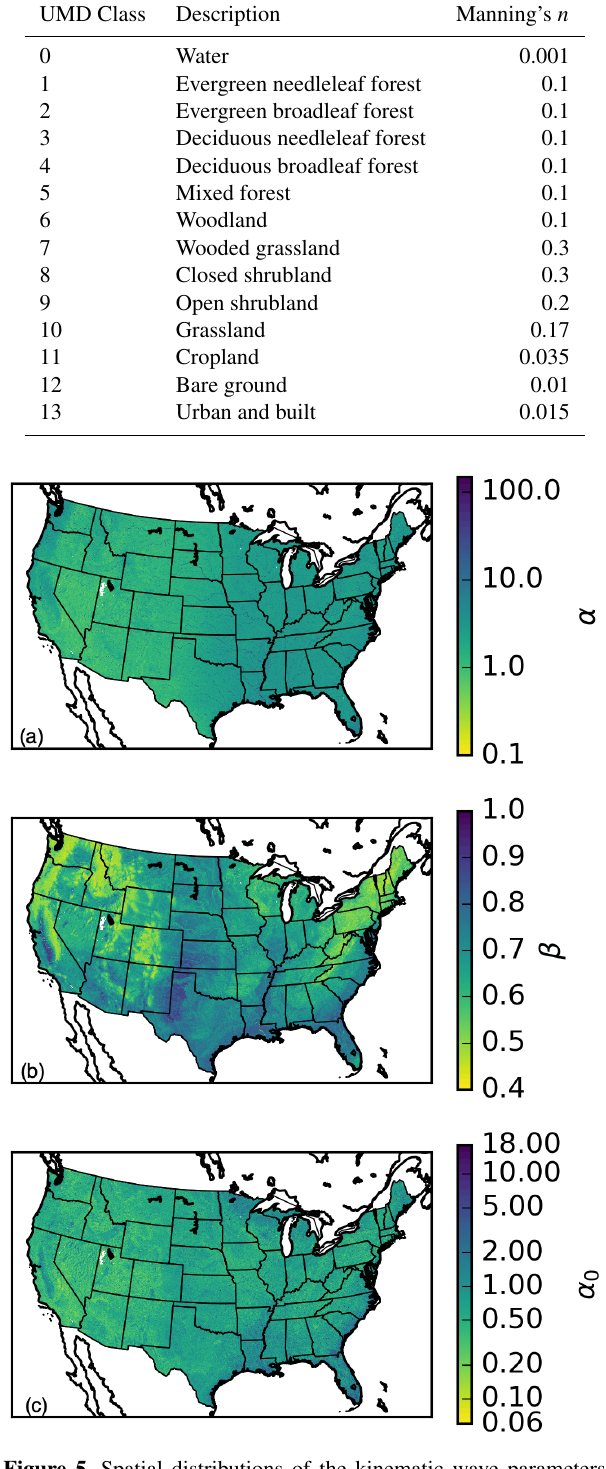
Figure 5. Spatial distributions of the kinematic wave parameters (a) α , (b) β , and (c) α 0 used over the CONUS in this study.